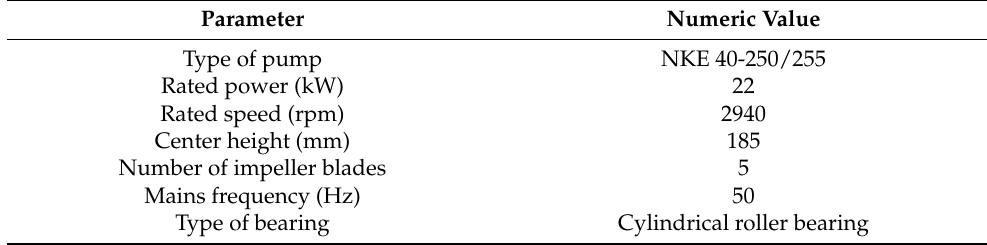
Table 2. Main parameters of the experimental pump.